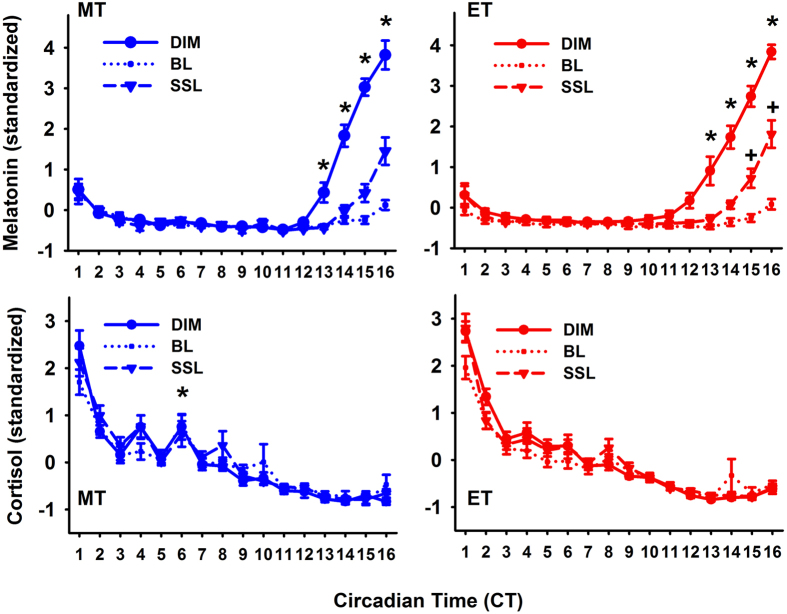
Time course of salivary melatonin concentrations (upper graphs) for morning types (MT; blue symbols; left) and evening types (ET; red symbols; right) for all three lighting conditions (dim light = DIM; constant bright light = BL; self-selected lighting = SSL; N = 32; means ± SEM).*Differences between DIM and both SSL and BL (p < 0.05); #significant difference for SSL and BL conditions (‘condition’ × ‘time’ for MT and ET separately p < 0.05). The data was standardized (z-transformation) and is plotted relative to habitual wake time (=CT 0). The lower two graphs show the time courses of salivary cortisol concentrations, again for both chronotypes: morning types (blue symbols; left) and evening types (red symbols; right) on standardized data. *Indicate significant differences between morning and evening types (main effect of ‘chronotype’; p < 0.05; see result section for exact p- and F-values).